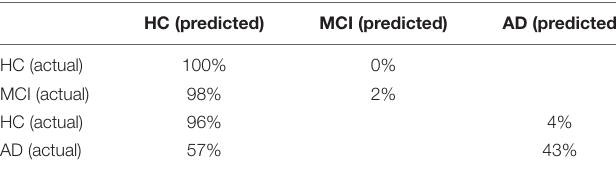
TABLE 8 | Confusion matrix of the SVM (linear) for the HC and MCI patients and the HC and AD patients classification using only eye tasks.